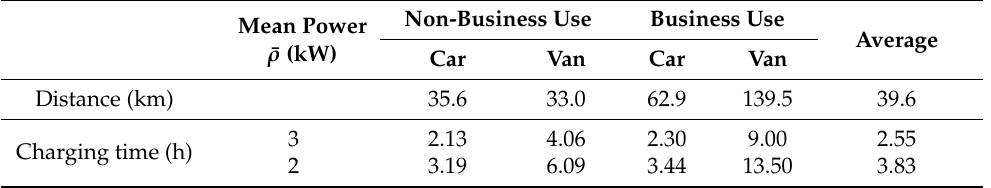
Table 7. Charging time per day (upper mean fuel efficiency α = 5.44 km/kWh and η = 0.95). Mean Power ¯ ρ (kW)